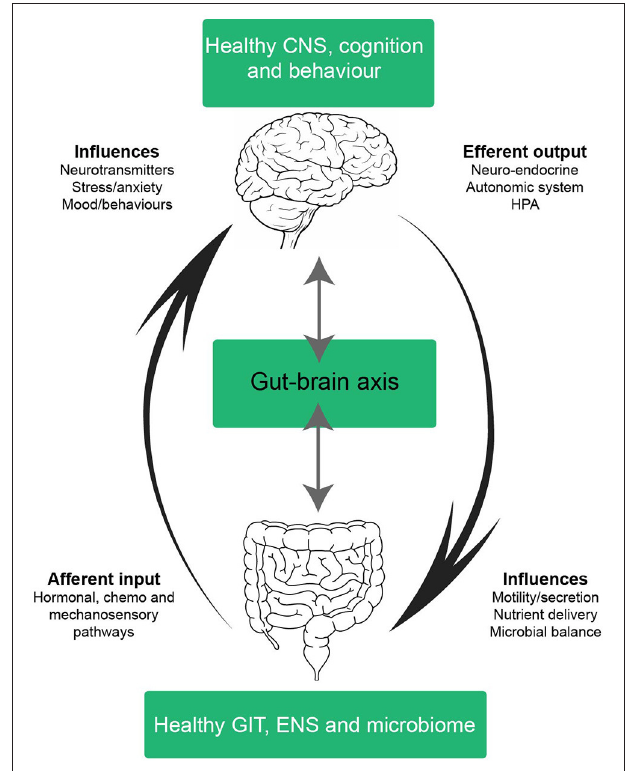
FIGURE 3 | Schematic of a healthy gut-brain axis. The arrows highlight the bidirectional nature of the gut-brain axis; in a balanced system mechanisms from the bottom-up (and vice versa) exist in cohesion. In a healthy system, the gut-brain axis integrates information from many systems; the central nervous system (CNS), autonomic nervous system (ANS), enteric nervous system (ENS), neuroendocrine, enteroendochrine, neuroimmune, and hypothalamic-pituitary axis (HPA). The complex bidirectional communication pathways and systems shared between the gut and the brain maintain health and homeostasis in the CNS, GIT, and microbiota. Efferent signals from the brain involving neuro-endocrine, autonomic and HPA outputs influence motility, secretion, nutrient delivery and microbial balance in the GIT. Whilst afferent inputs from the GIT, such as intestinal hormones, cytokines and sensory perceptions influence neurotransmitter expression, stress, anxiety, mood and behavior. CNS, central nervous system; ANS, autonomic nervous system; ENS, enteric nervous system; HPA, hypothalamic-pituitary axis; GIT, gastrointestinal